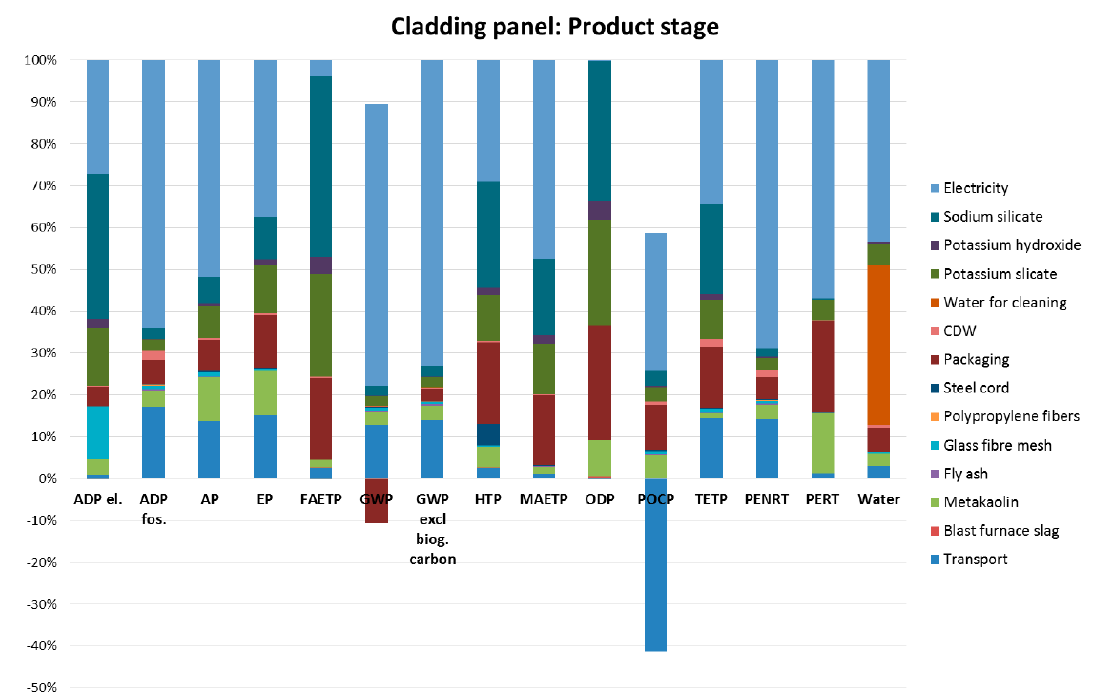
Figure 5. The contribution analysis of the model results for the product stage of the prefabricated geopolymeric façade cladding panel (the figure was produced by the authors).